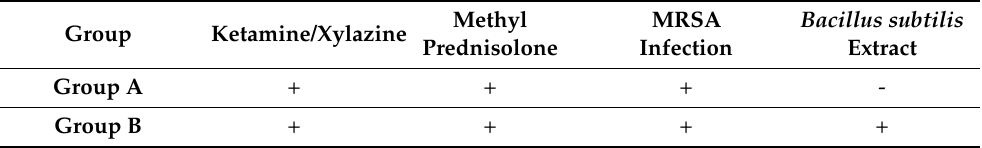
Table 3. Treatment